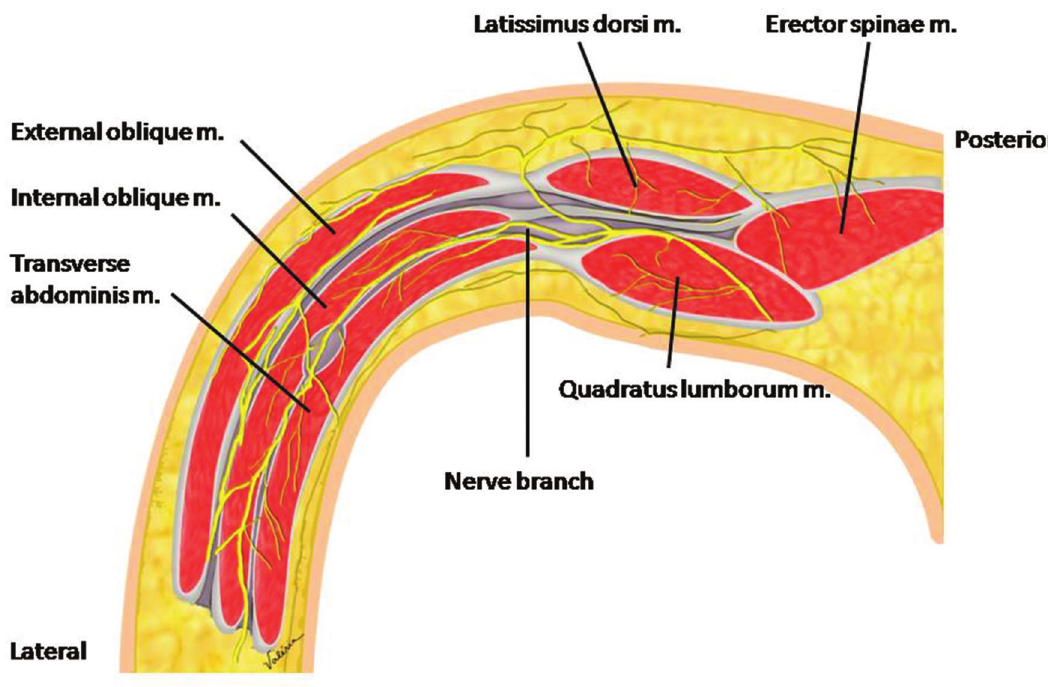
Figure 2 - Cross section showing the inter-muscular plane between the IO and TA muscles with the nerve branches to be blocked.